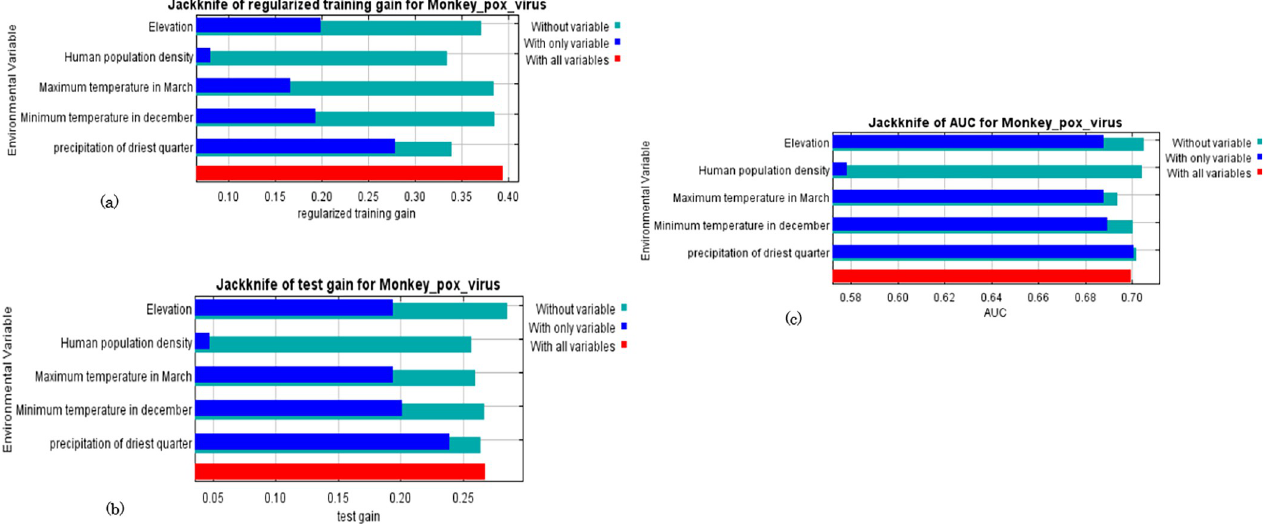
Fig 4. Summary of the Jackknife analysis performed to determine importance of each environmental